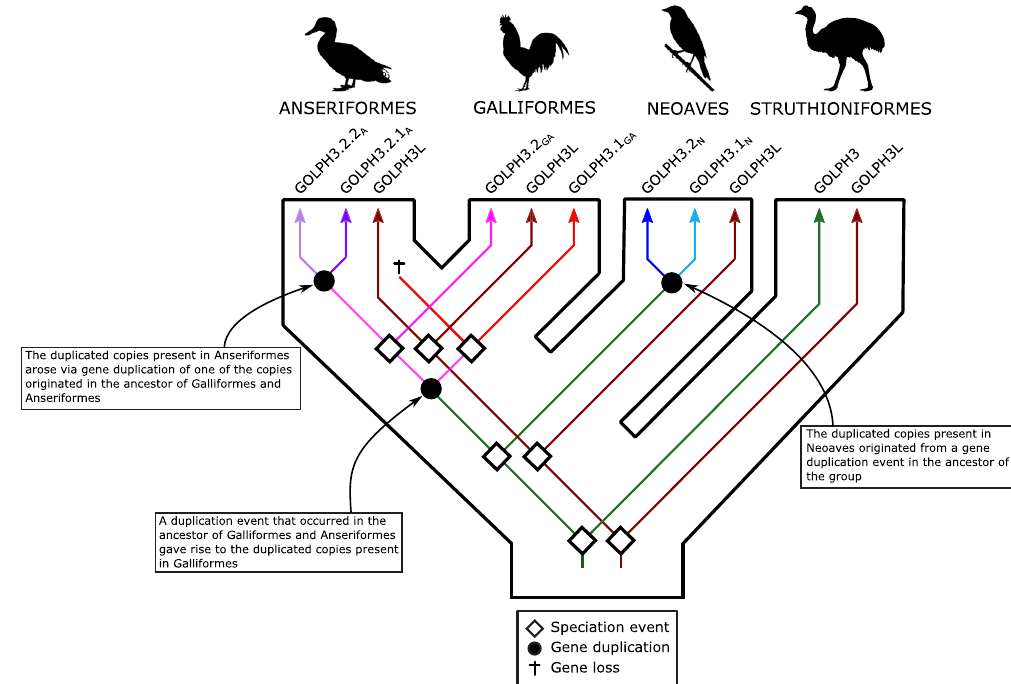
Figure 2. An evolutionary hypothesis regarding the evolution of the Golgi phosphoprotein 3 (GOLPH3) gene family in birds. According to our results, the last common ancestor of birds had a repertoire of two GOLPH3 genes (GOLPH3 and GOLPH3L). The GOLPH3L gene was inherited by all species of birds and maintained as a single copy gene (brown lineage). The evolution of the GOLPH3 gene is more complicated. The gene present in the bird ancestor was inherited by paleognaths (ostriches, tinamous and allies) and maintained as a single copy gene in most species. In the case of Neoaves (zebra finches, kakapos and allies), the ancestral GOLPH3 gene underwent a duplication event in the ancestor of the group giving rise to a repertoire of two genes (blue and light blue gene lineages). In the last common ancestor of Anseriformes (ducks, swans and allies) and Galliformes (chickens, pheasants and allies) the ancestral GOLPH3 gene underwent a duplication event giving rise to a repertoire of two genes, one of the copies was retained in Galliformes (red lineage), but lost in Anseriformes (red lineage). The other copy originated in the ancestor of Galliformes and Anseriformes, was also retained in Galliformes (pink lineage), however, in the last common ancestor of Anseriformes underwent a duplication event giving rise to the repertoire of two copies (purple and light purple lineages). We use the subscripts to indicate the ancestor in which the gene repertoires were originated, N = the ancestor of Neoaves, A = the